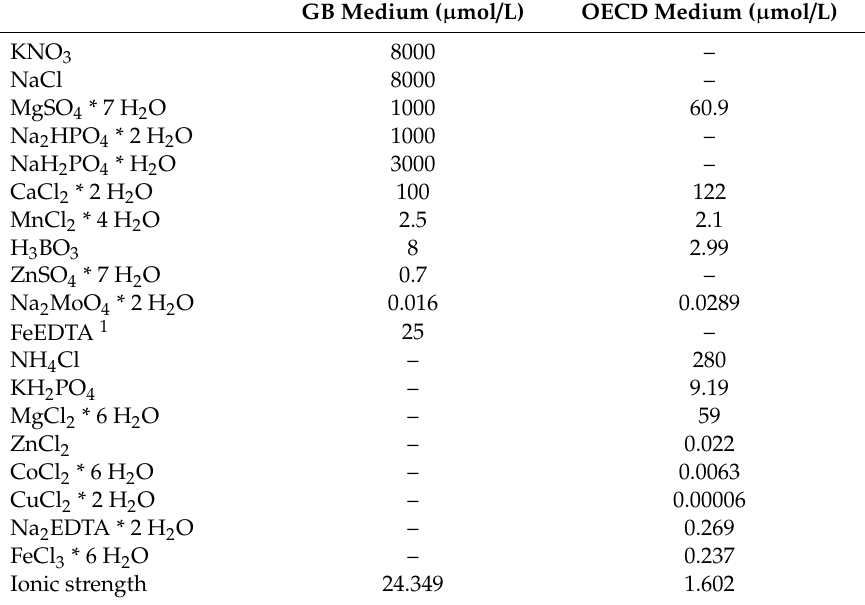
Table 2. Composition of Grimme–Broadman (GB) medium [16] and OECD medium